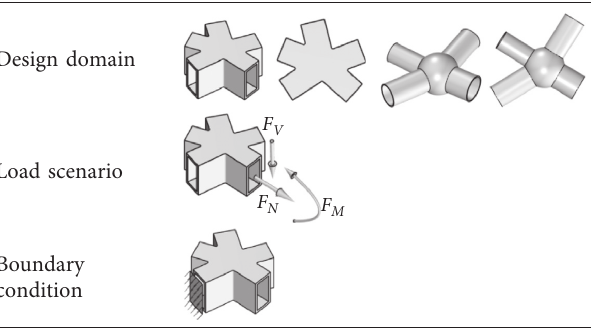
Table 6: Parameters for joint